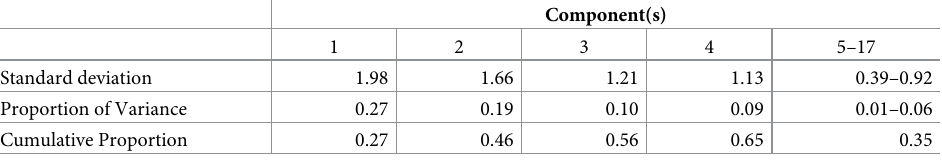
Table 3. Standard deviation, proportion of variance and cumulative proportion of variance of components (c1-c17) from a principal component analysis of working dog personality